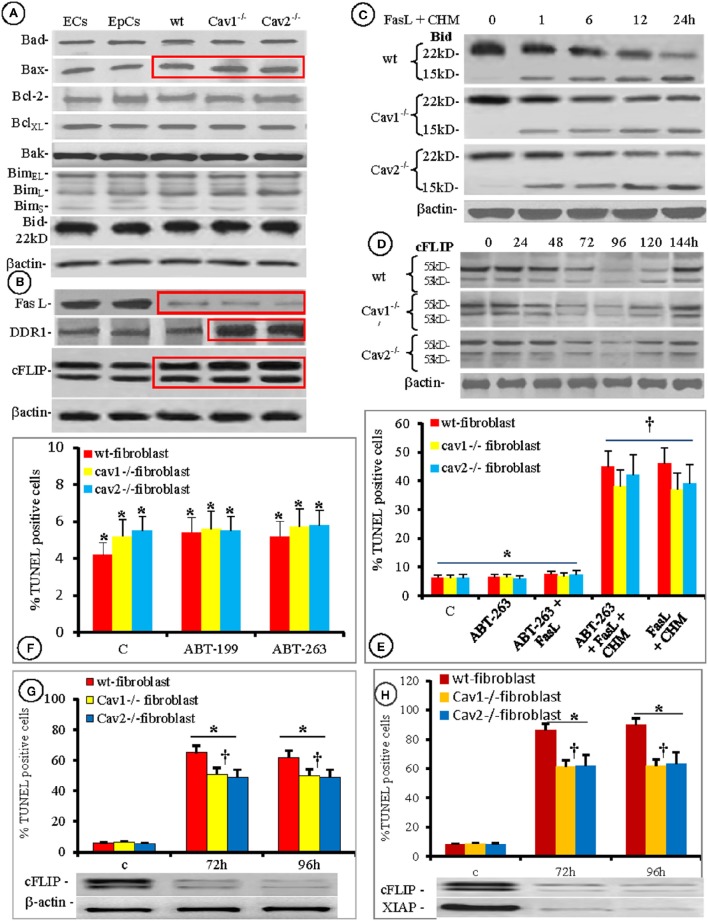
Contribution of Bcl-2 family members, cFLIP, and XIAP to fibroblasts' increased resistance to apoptosis. Protein expression of seven members of Bcl-2 family of apoptotic proteins shows that in different types of lung cellular populations, only Bax is constitutively overexpressed (red box); n = 5 for each type of cells. (B) Expression of other apoptotic proteins, in the same types of isolated cells showing (red rectangles): FasL downregulation, DDR1 upregulation–especially in Cav-null fibroblasts, and cFLIP upregulation in all fibroblasts; n = 5 for each type of cells. (C) Presence of cleaved form of Bid (15 kD fragment on isolated fibroblasts treated with FasL and CHM), is easily detected with a specific anti tBid Ab; n = 7 for each time point. (D) The transitory effect of siRNA silencing of cFLIP showing its temporary down regulation between 72 and 120 h; n = 5 for each type of fibroblasts and every time point. (E) Pharmacologic inhibition of Bcl-2 (E,F) shows no effect on fibroblasts resistance to apoptosis by the broad specific ABT-236 (F) or by the more specific ABT-199 (E) as detected by the TUNEL reaction; n = 8 for every type of fibroblast, *p < 0.3. However, †p < 0.001 when the fibroblasts were treated with FasL + CHM even in the presence of ABT-236; n = 6 for every type of fibroblasts and the experiments were repeated three times. (G) Increased apoptotic susceptibility of cells to FasL in cFLIP knockdown fibroblasts; n = 7, *p < 0.01 when compared with the controls and †p < 0.05 in between wt and cav-null fibroblasts. (H) Double XIAP/ cFLIP knockdown shows an additive effect on apoptosis resistance to FasL treatment. n = 7, *p < 0.05 when compared to control and †p < 0.01 in between wt and Cav-null fibroblasts.